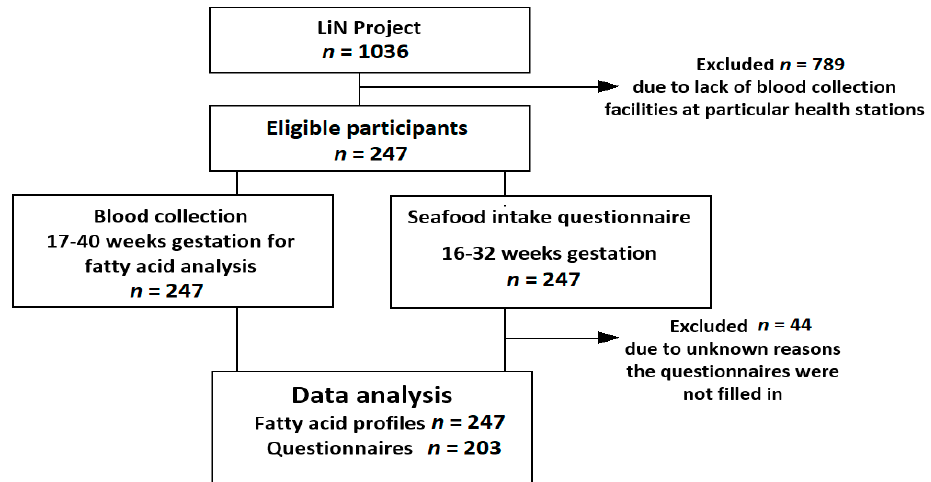
Figure 1. Flow chart of the study population, including reasons behind patient exclusion and refusals.